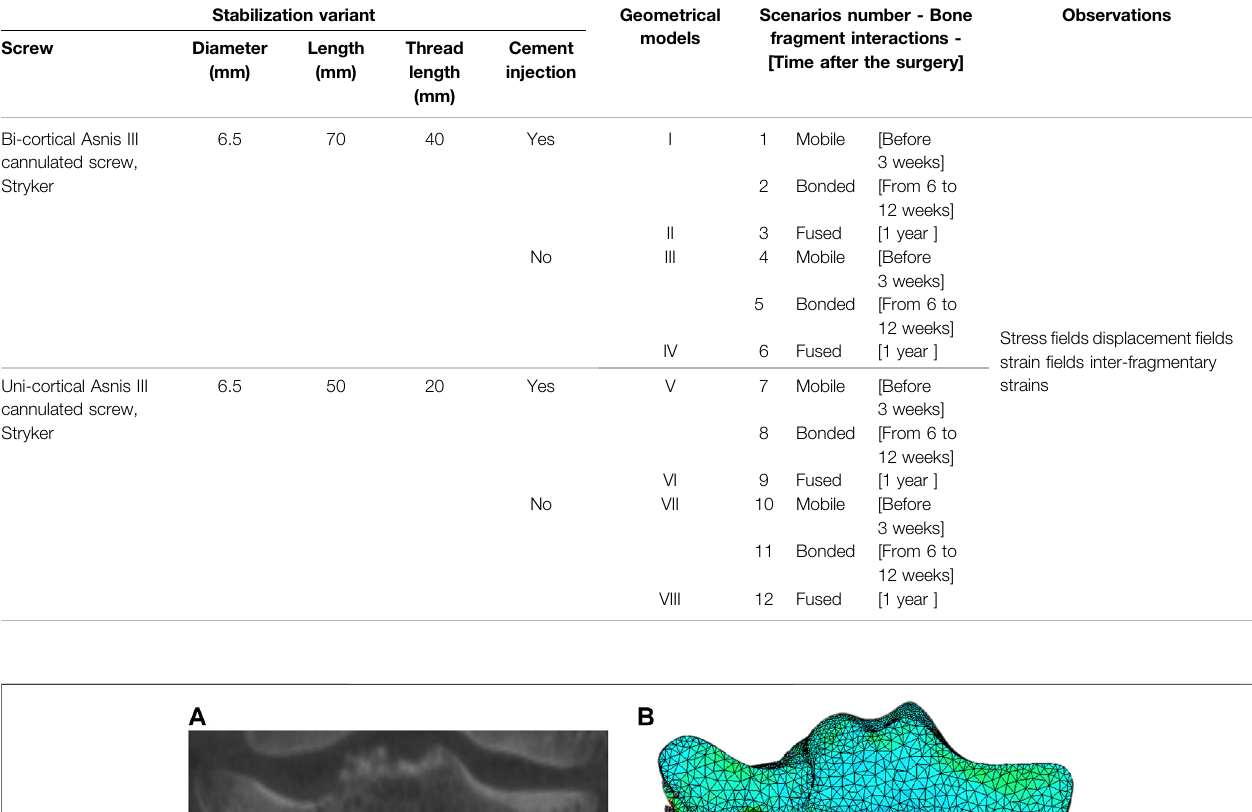
TABLE 1 | Description of the 12 simulated scenarios including stabilization variant characteristics and bone healing conditions.